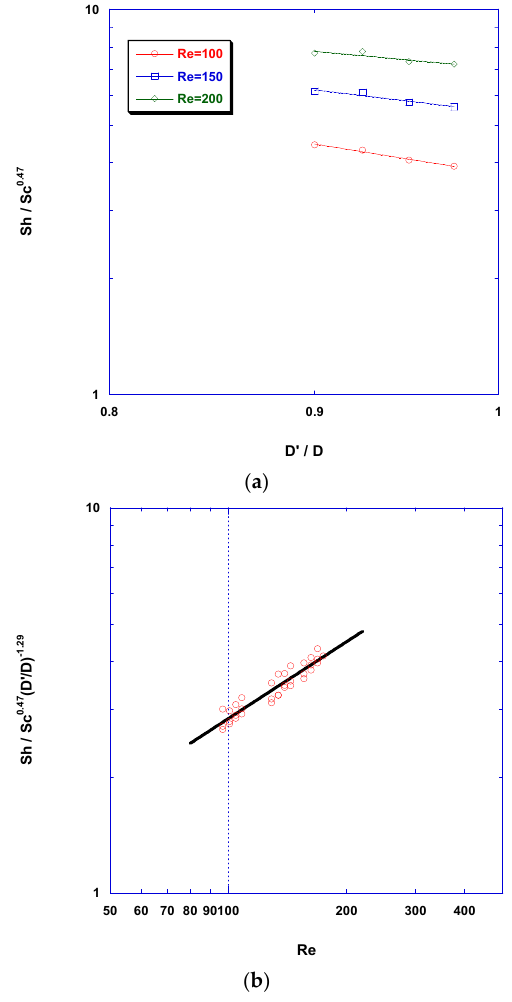
Figure 11. ( a ) Time and space-average Sh number, on the membrane surface, as a function of ratio D ’/ D ; ( b ) correlation of dimensionless Sh number parameter (involving Sc and D ’/ D ) as a function of Re number.